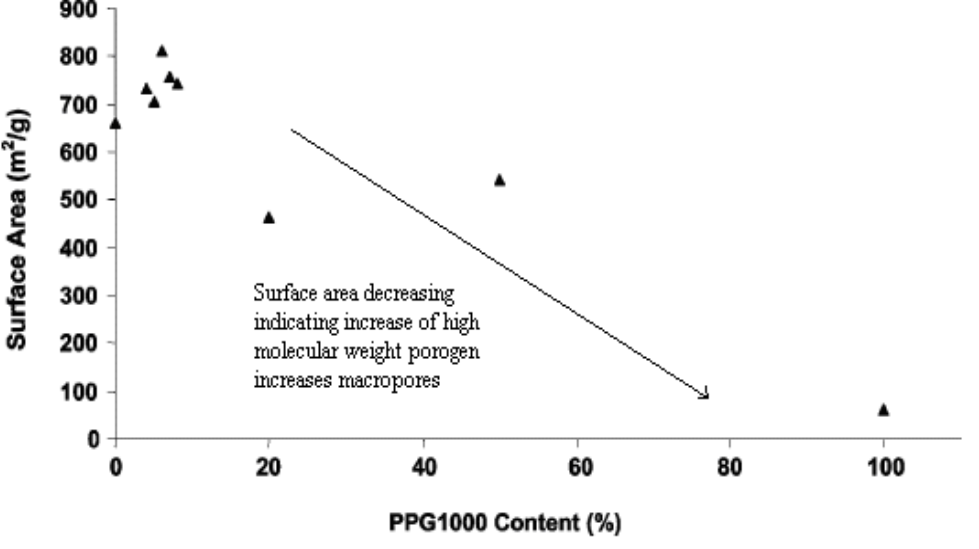
Figure 6. Plot of surface area (N BET) vs. PPG-1000 co-porogen content (vol %) for dry 2 state poly(DVB) resins showing a maximum ~6 vol % PPG-1000. (Reprinted (adapted) with permission from [18]. Copyright 2004 American Chemical